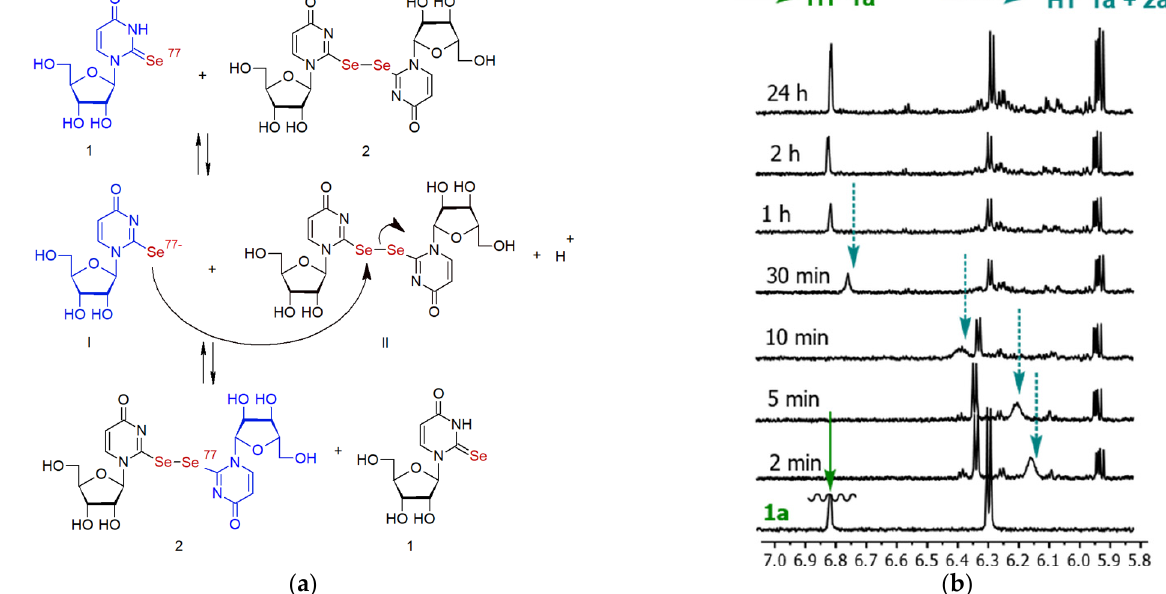
Figure 4. ( a ) Schematic presentation of the Se2U/(Se2U) 2 exchange reactions performed with diselenide (Se2U) 2 (containing a selenium isotope mixture of natural abundance) and 77 Se2U (containing 100% 77 Se), as discussed in Sect. 2.6; ( b ) 1 H NMR spectral set collected for the oxidation Se2U with a molar ratio of 1 to H 2 O 2 of 1:0.5, observed between 2 min and 24 h of the reaction course. The signals of H1 (cid:48) of 1 at δ 6.80 ppm and 1 / 2 exchange species (at δ 6.15 ppm/2 min, 6.20/5 min, 6.4/10 min, and 6.75 at 30 min) are indicated by the